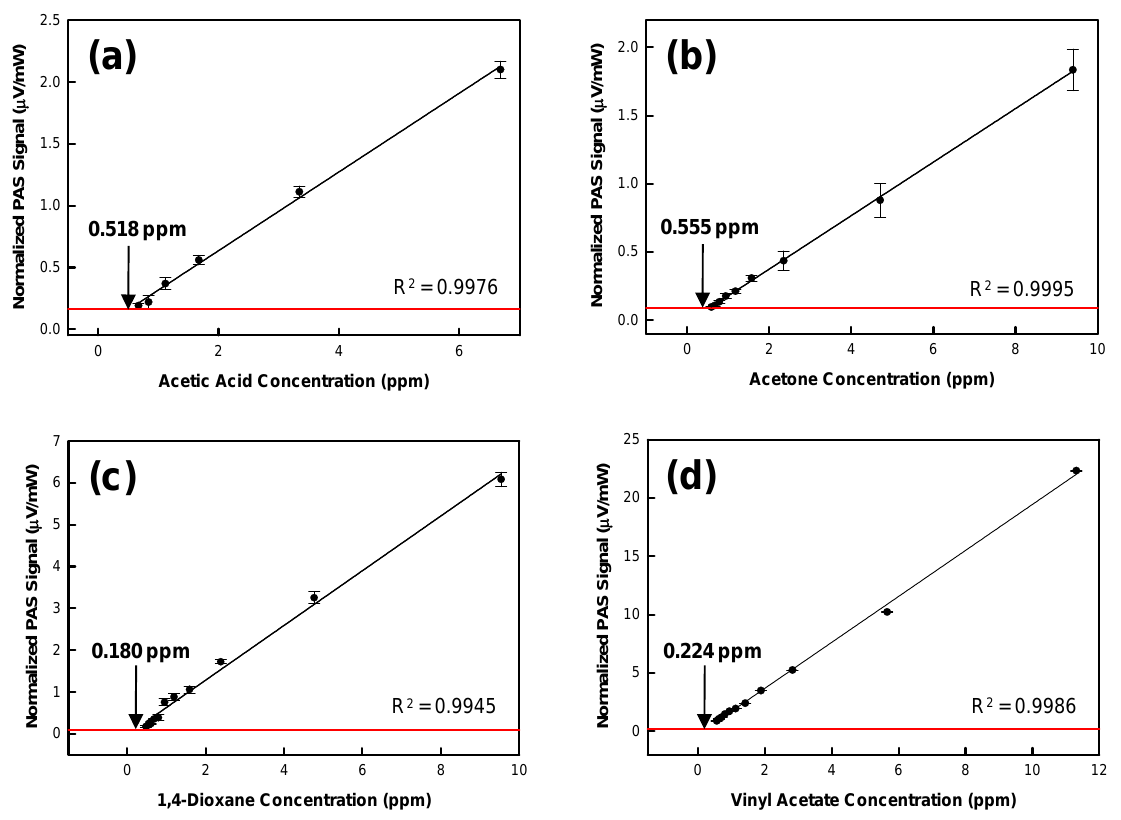
Figure 5. Photoacoustic sensor response as a function of (a) acetic acid; (b) acetone; (c) 1,4-dioxane; and (d) vinyl acetate concentration. Error bars represent one standard deviation. The red line represents three standard deviations (3 σ ) of the background signal. A linear function has been fit to the data.